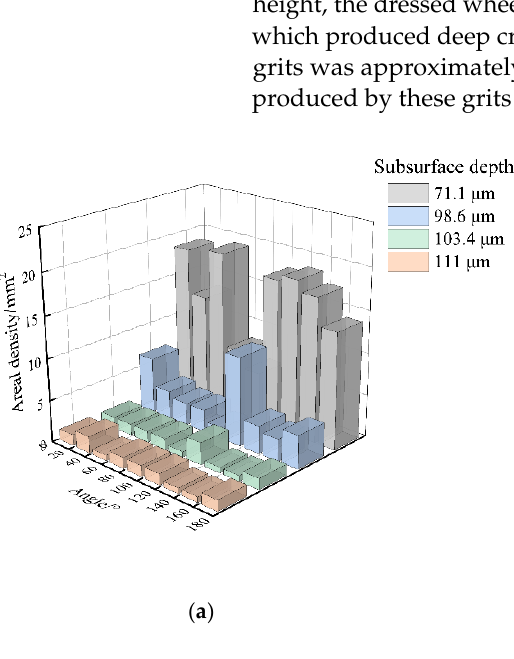
Figure 12. Variation in crack angles with depths under different worn wheels: ( a ) Undressed wheel and ( b ) dressed wheel.